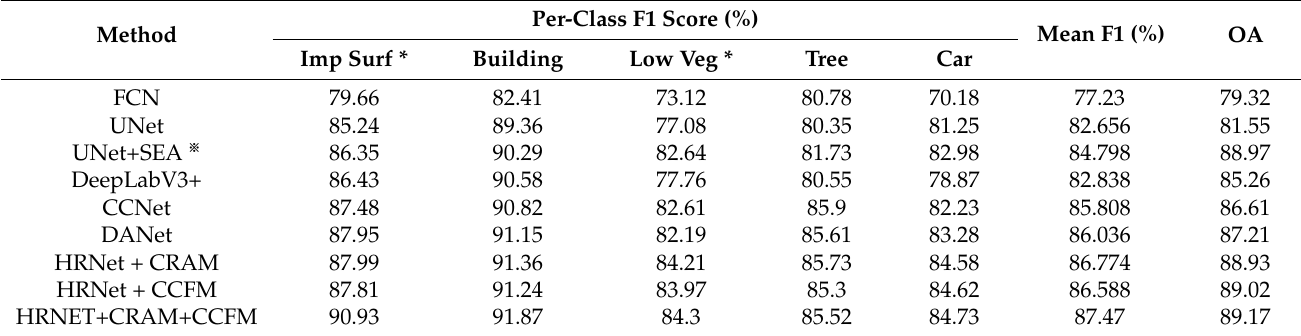
Table 4 . Comparison with the state-of-the art on the Vaihingen Dataset Table 4. Comparison with the state-of-the art on the Vaihingen Dataset Method